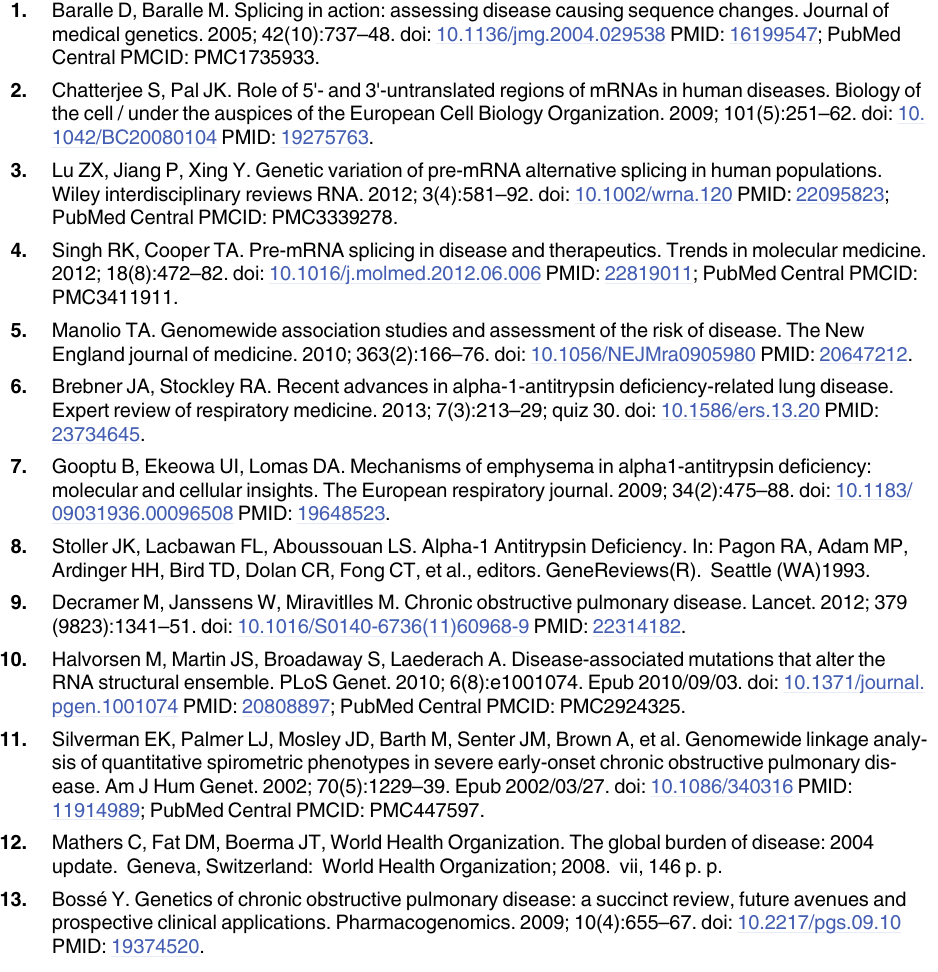
S8 Table. Overlap between Literature Review and GWAS identified genes in disease and control sets. S9 Table. Genes associated with idiopathic pulmonary fibrosis.